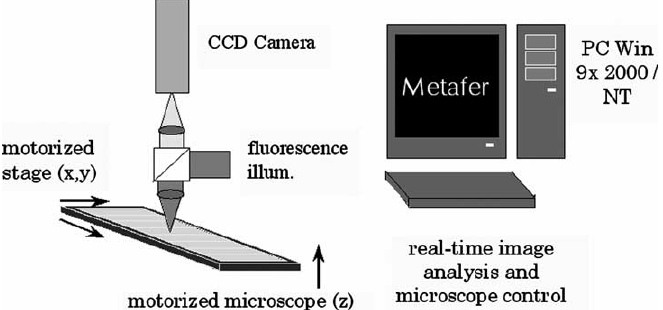
Fig. 1. Set-up of slide scanning platform